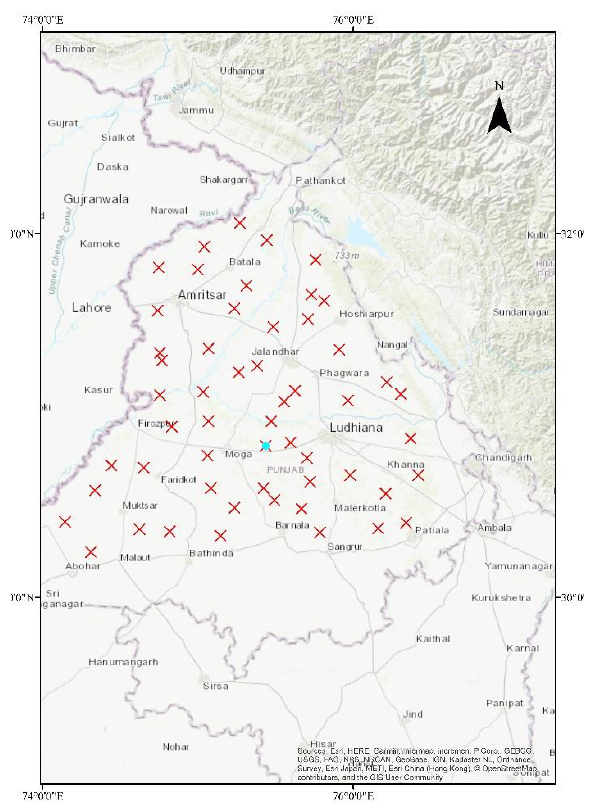
Figure 1: Map of study area- Punjab (North-western state), also known as food basket of India.